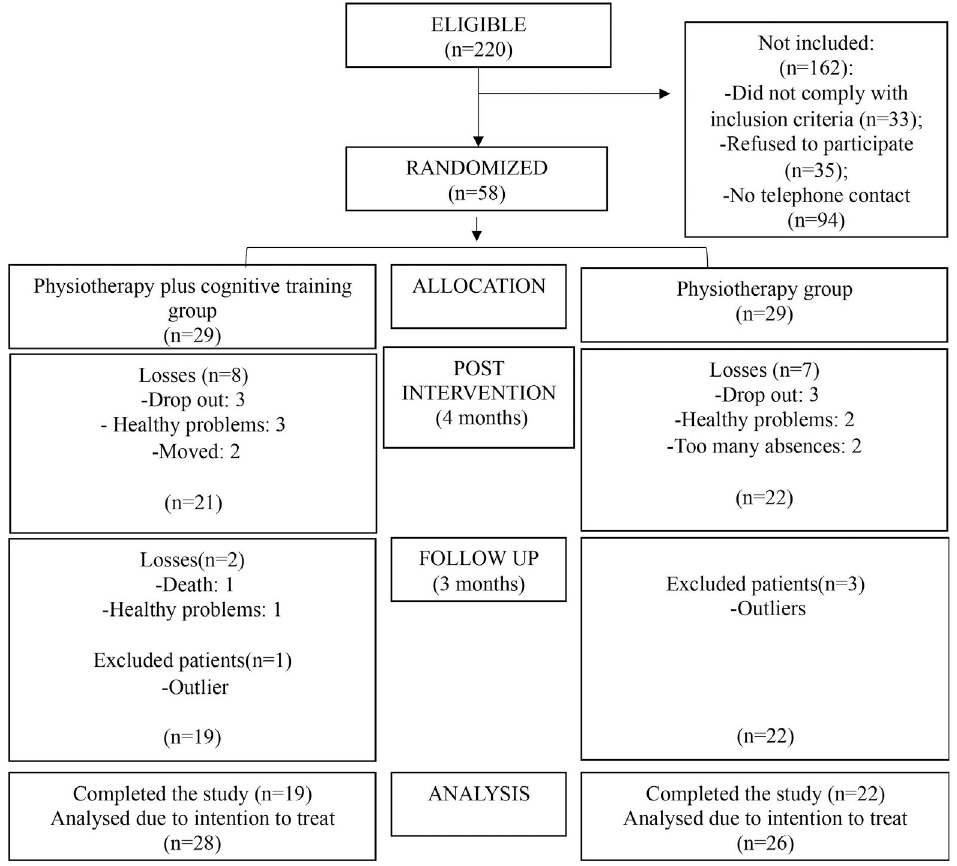
Figure 1 - Consort diagram. Flow diagram of the